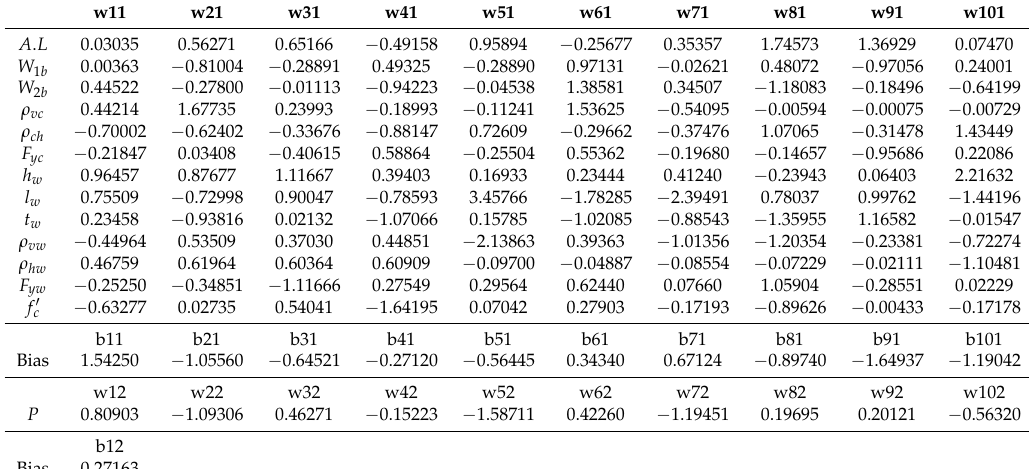
Table A5. Detailed meta-model for strength response of RCSW.